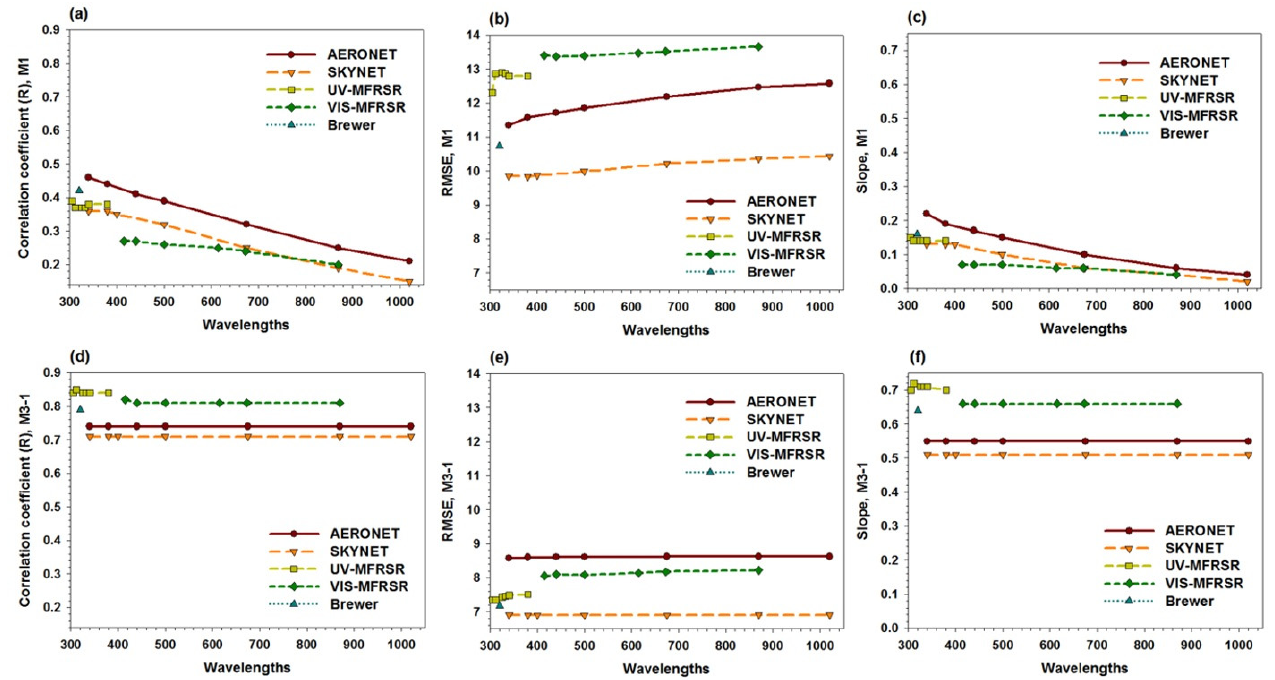
Figure 4. Wavelength dependence of ( a ) R, ( b ) RMSE, and ( c ) slope values of the M1 model, and that of ( d ) R, ( e ) RMSE, and ( f ) slope values of the M3-1 model using multiple ground-based AODs. The unit of RMSE is μ g/m 3 .